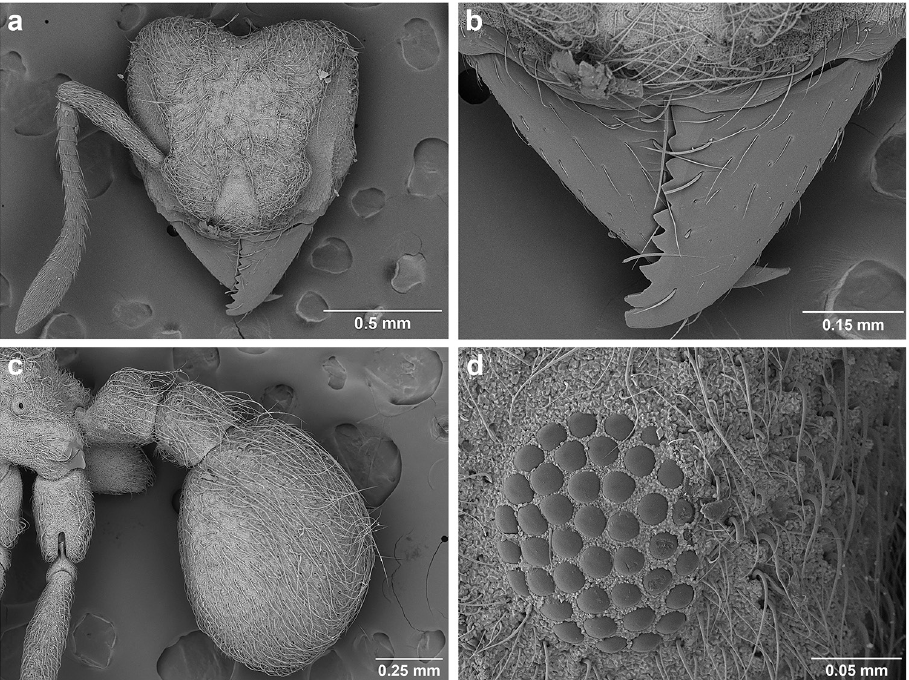
Figure 54. S. saramama worker (USNMENT01125262), SEM images. a Head, full-face view b man- dibles c metasoma, lateral view d